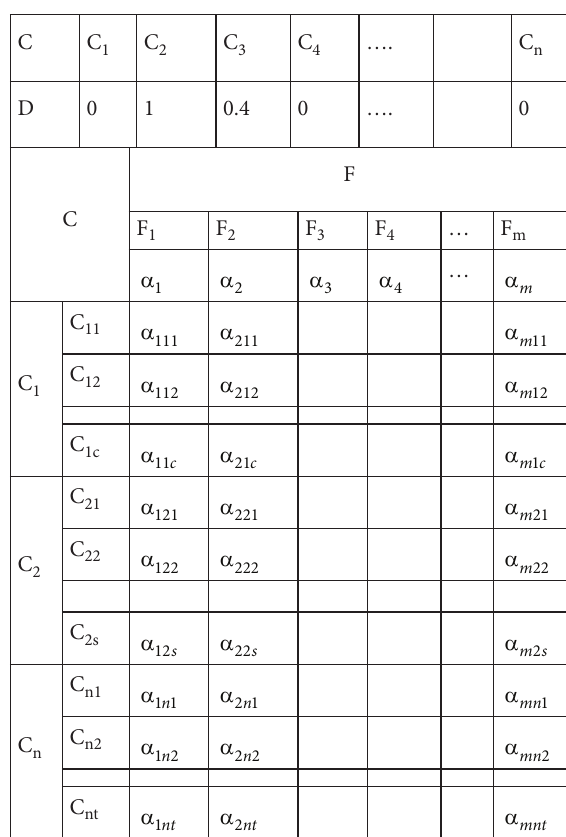
Table 1. Presentation of output information on